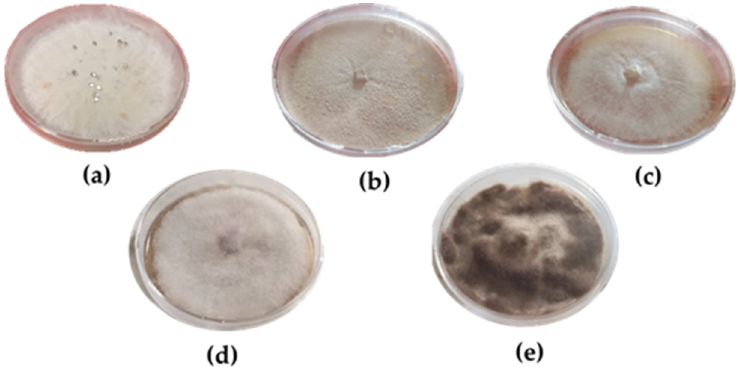
Figure 7. Fungal isolates grown on PDA medium. ( a ) S. rolfsii , ( b ) P. chrysosporium , ( c ) T. cingulata , ( d ) F. verticillioides and ( e ) B. cinerea.